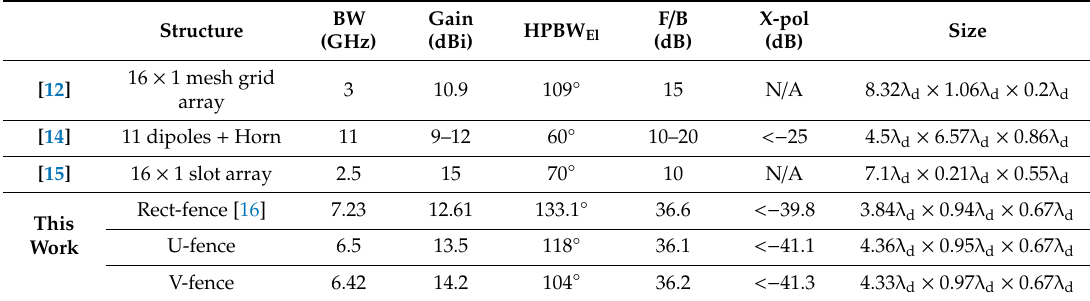
Table 2. Comparison with state-of-the-art 28 GHz linearly polarized mobile device antennas.